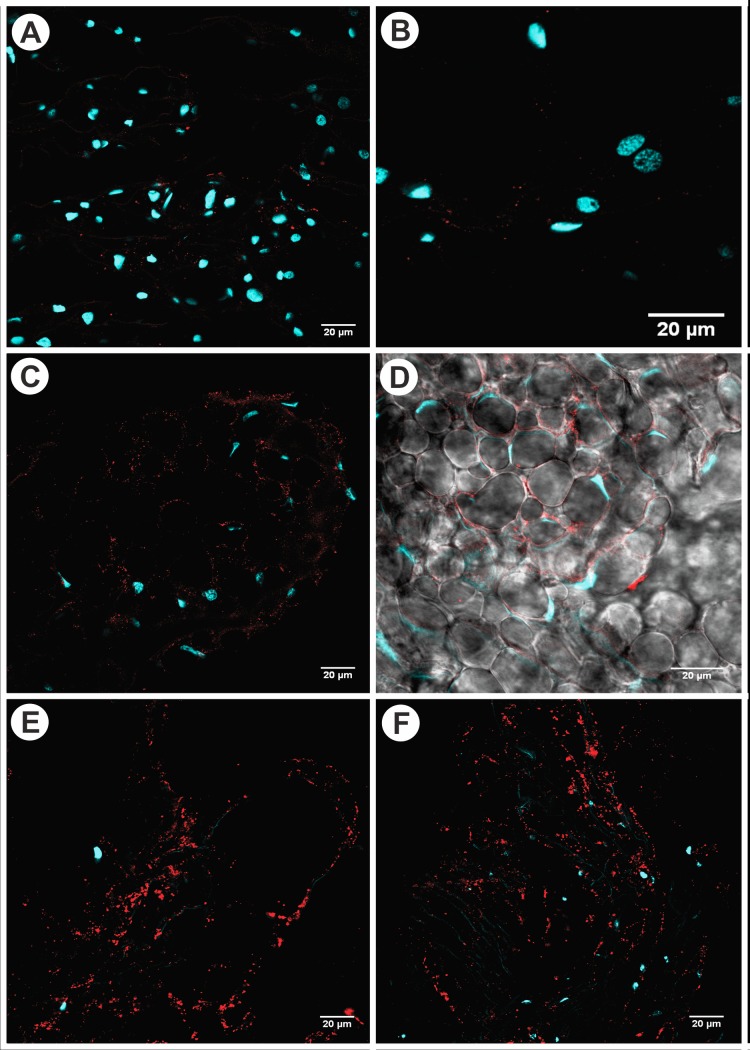
Confocal microscopy of postpharyngeal glands of Atta sexdens rubropilosa showing the fluorescence of the enzyme acyl-CoA dehydrogenase.(A-B)—Detail of the digitiform prolongation showing the nuclei of glandular cells of mated females from the group without lipid supplementation (FAST 120 h), stained blue (DAPI), and the low enzymatic activity of acyl-CoA dehydrogenase (red) in the glandular cells. (C-D)—Detail of the digitiform prolongation showing the nuclei of glandular cells in the PPG of mated females from the group supplemented with lipids (LIPID 48 h), stained blue (DAPI), and the moderate enzymatic activity of acyl-CoA dehydrogenase (red) in the glandular cells. It can be seen that the enzyme acyl-CoA dehydrogenase is primarily distributed along the lateral area of glandular cells (DIC) of the digitiform prolongation in the PPG. (E-F)—Detail of the digitiform prolongation showing the nuclei (blue) of glandular cells in the PPG of mated females from the group supplemented with lipids (LIPID 120 h), stained blue (DAPI), and the high enzymatic activity of acyl-CoA dehydrogenase (red) in the glandular cells.